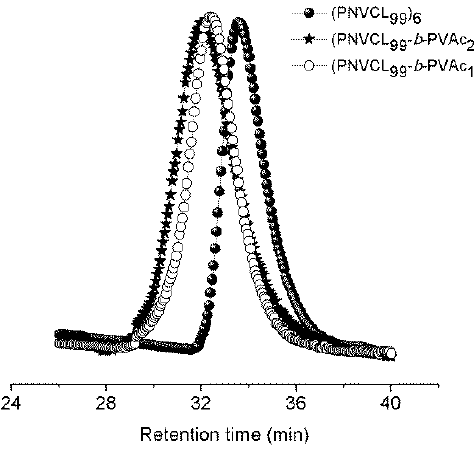
Figure 4. Normalized Gel permeation chromatography (GPC) traces in THF for star (PNVCL) 6 polymers and star (PNVCL- b -PVAc) 6 block copolymers.